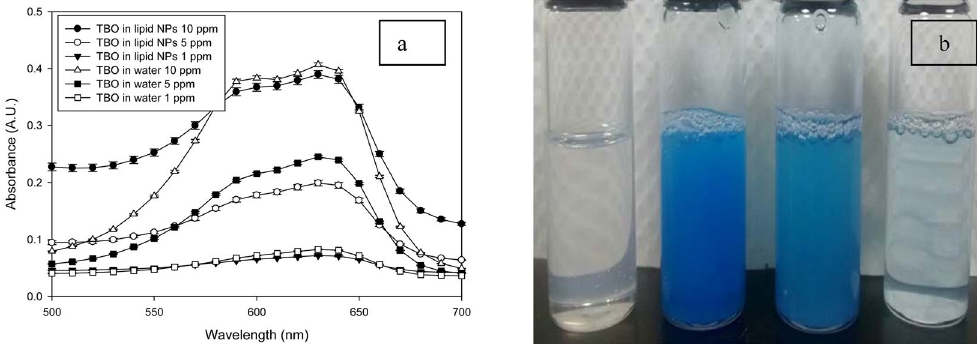
Figure 1. ( a ) UV-vis absorbance spectra of TBO in lipid nanoparticles formulation containing 1, 5, 10 ppm TBO. ( b ) Sample vials positioned from left to right are as follows: lipid nanoparticles formulation without TBO; TBO in lipid nanoparticles at a concentration of 10 ppm; 5 ppm and 1 ppm, respectively.